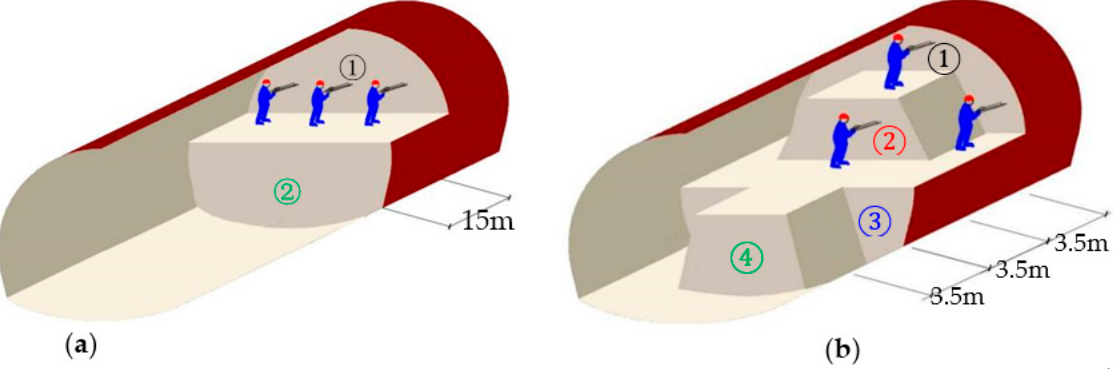
Figure 3. Schematic diagram of tunnel excavation: ( a ) Long step method; ( b ) Reserved core soil method. ① ~ ④ is the excavation sequence of surrounding rock . Table 1. Physical and mechanical parameters of surrounding rock and